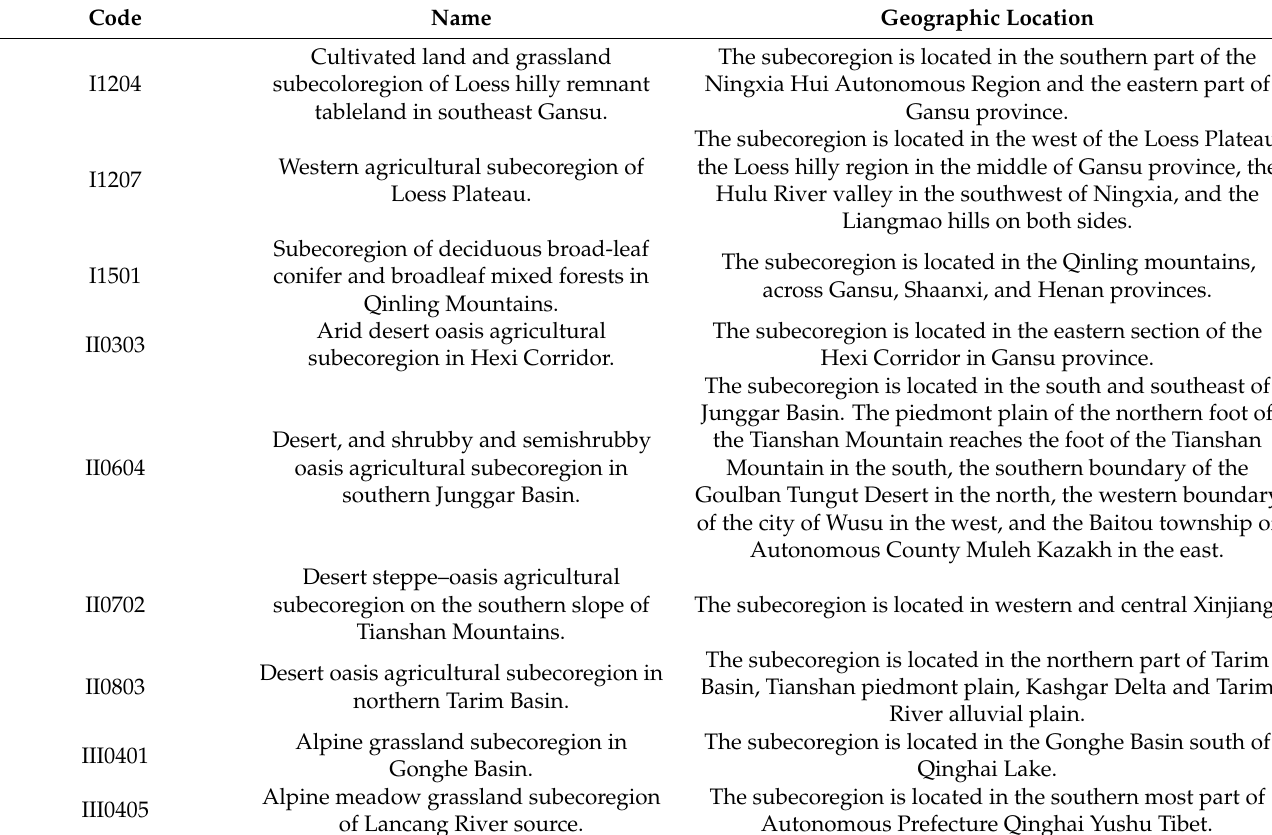
Table 2. Subecoregion